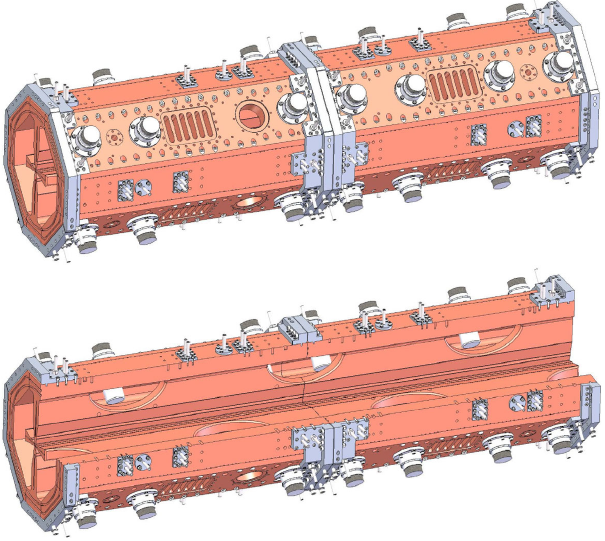
FIG. 1. Detailed 3D engineering model of the copper RFQ cavity made in two segments. The adjustable aluminum tuners will be replaced with fixed copper tuners after low-power tuning.